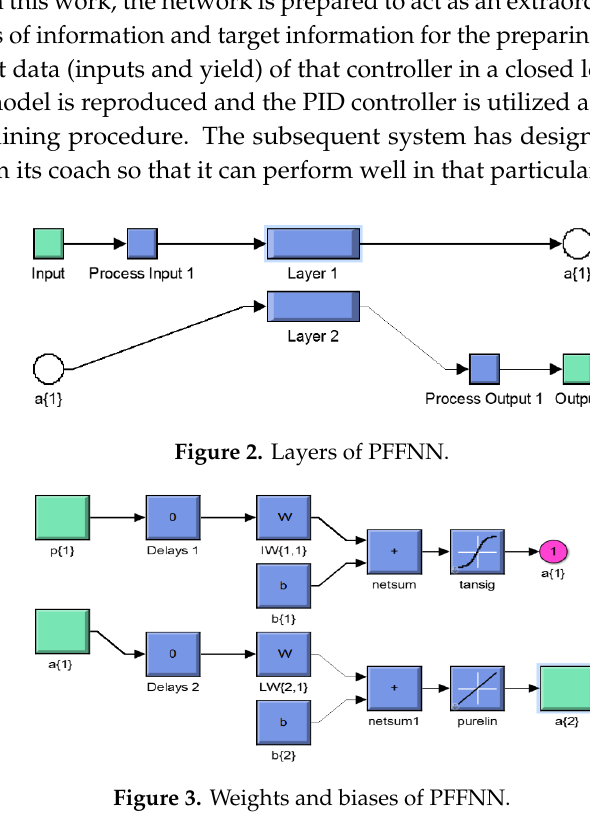
Figure 3. Weights and biases of PFFNN.